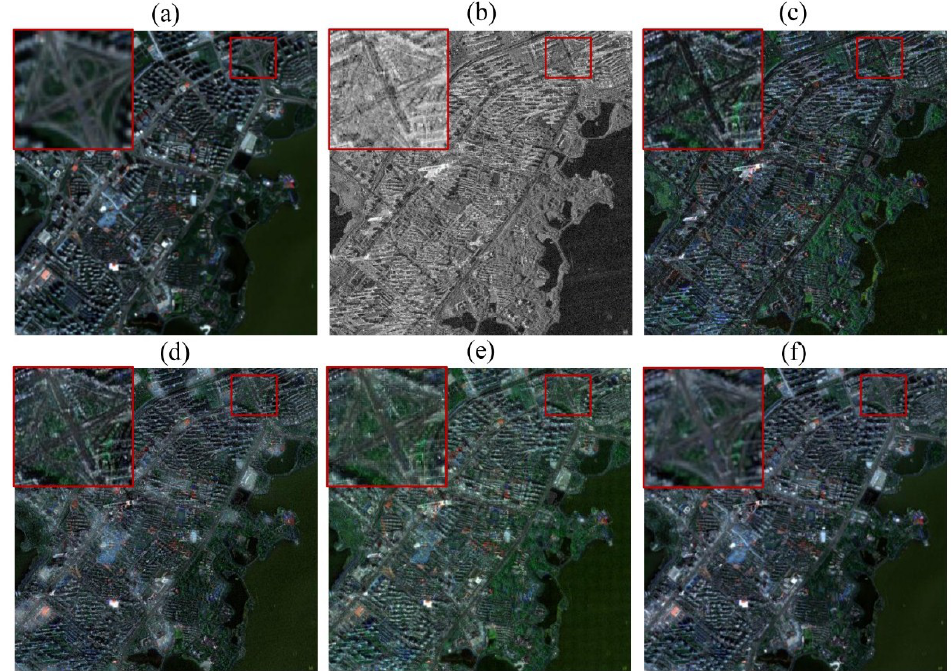
Figure 3. The source images and the fused images with different methods for Site 1: ( a – f ) Sentinel-2A image, TerraSAR image, and the fusion results of IHS, GTF, DWT, and IHS-GTF, respectively.